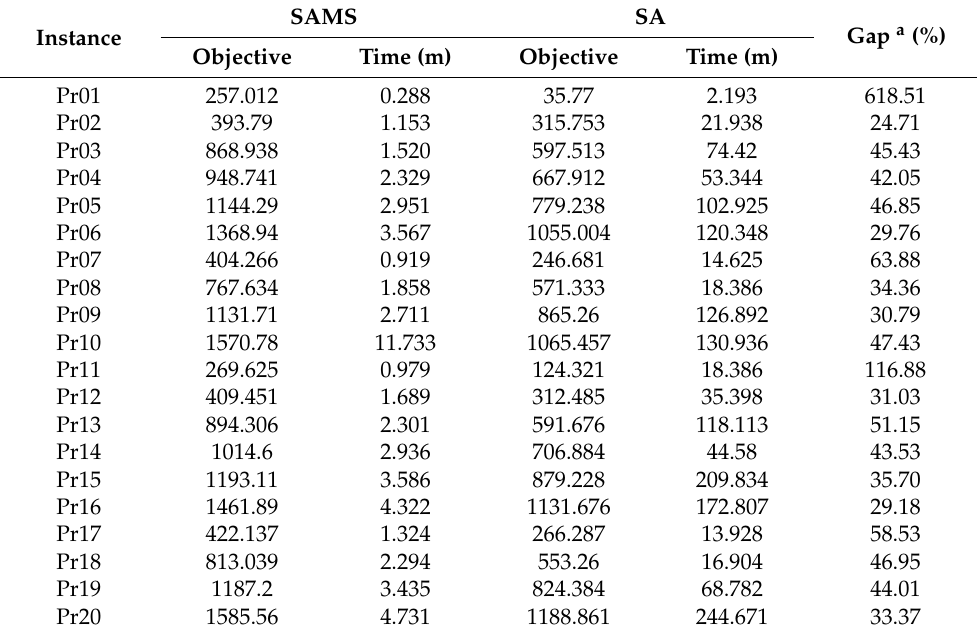
Table 3. Comparison between proposed SAMS and SA solution for SARP large